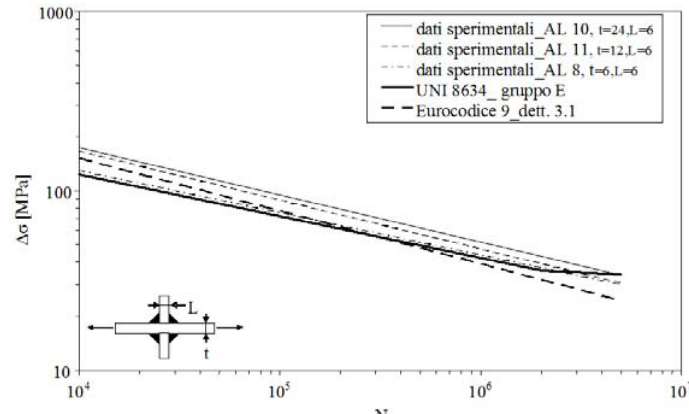
Figura 11: Confronto tra curva di resistenza a fatica per lamiere con irrigidimenti trasversali simmetrici (giunti a croce,cordone non portante).